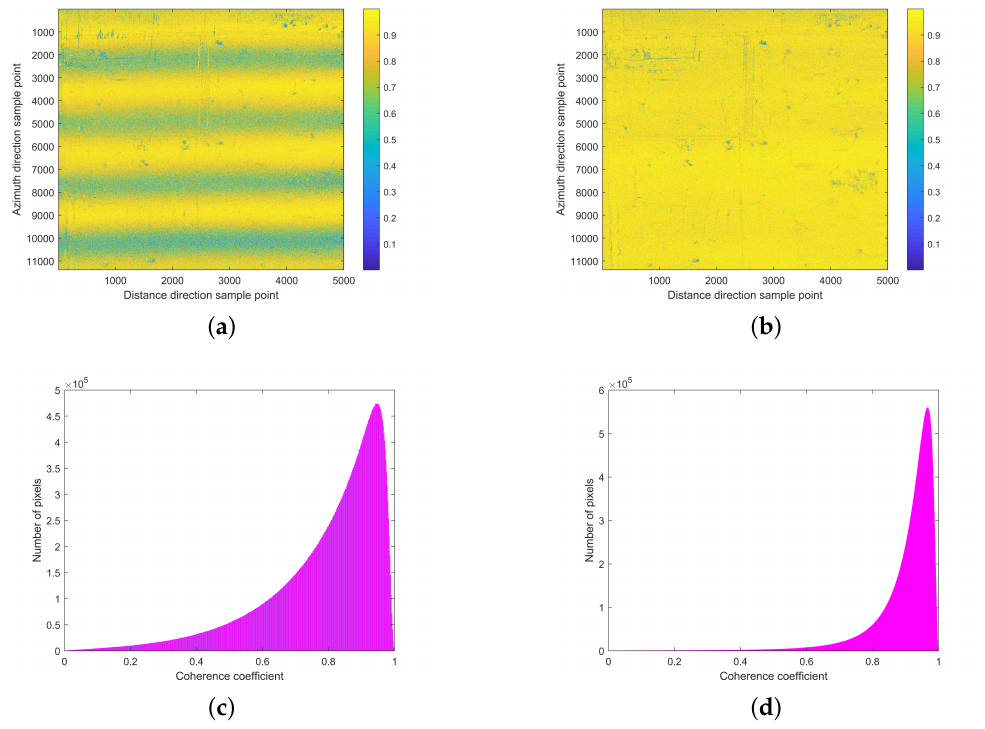
Figure 20. The comparison results. ( a ) The comparison method coherence coefficient diagram; ( b ) the proposed method coherence coefficient diagram; ( c ) the comparison method coherence coefficient statistical histogram; ( d ) the proposed method coherence coefficient statistical histogram.